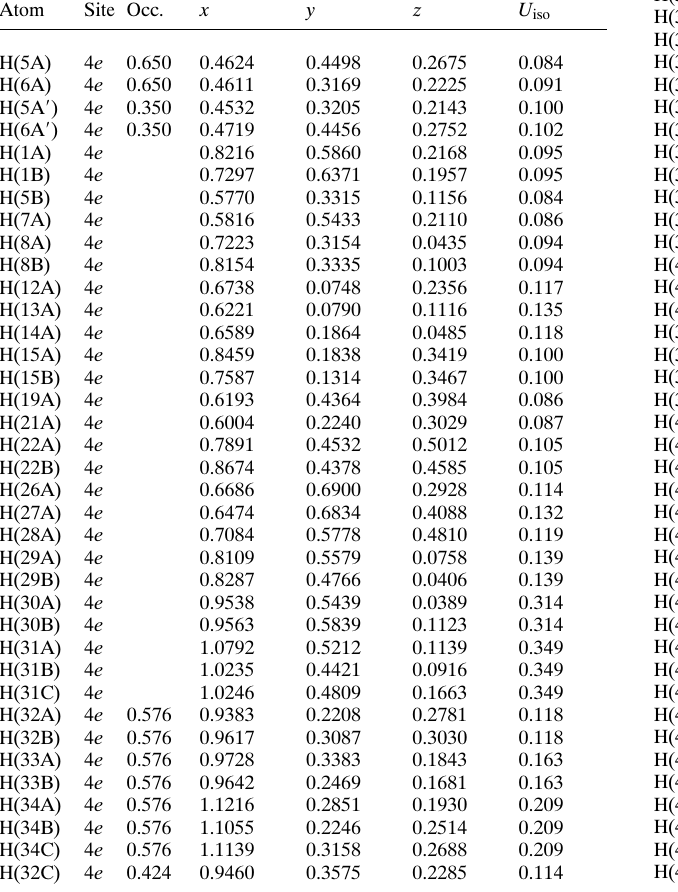
Table 2. Atomic coordinates and displacement parameters (in Å 2 ) . Atom